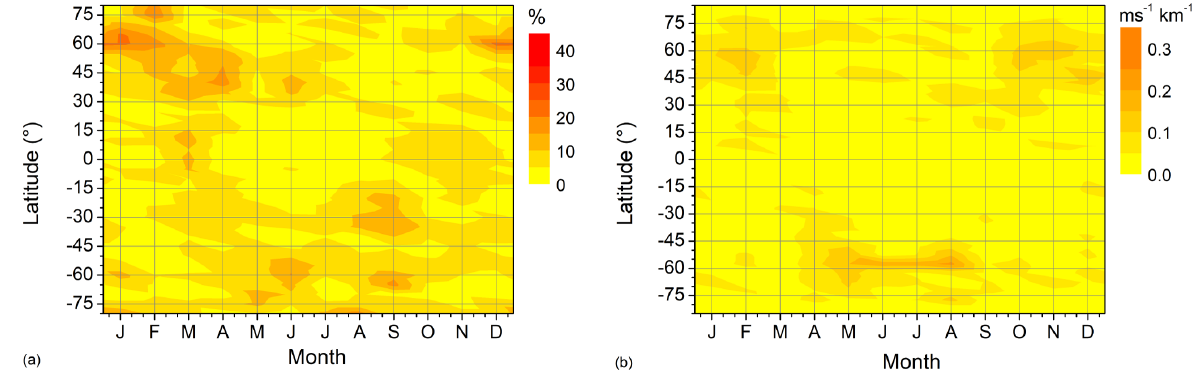
Figure A4. (a) 2007–2016 mean monthly mean QDT Es relative amplitudes at 95km. (b) MUAM zonal wind shear at the nearest model level at 95 . 2km.